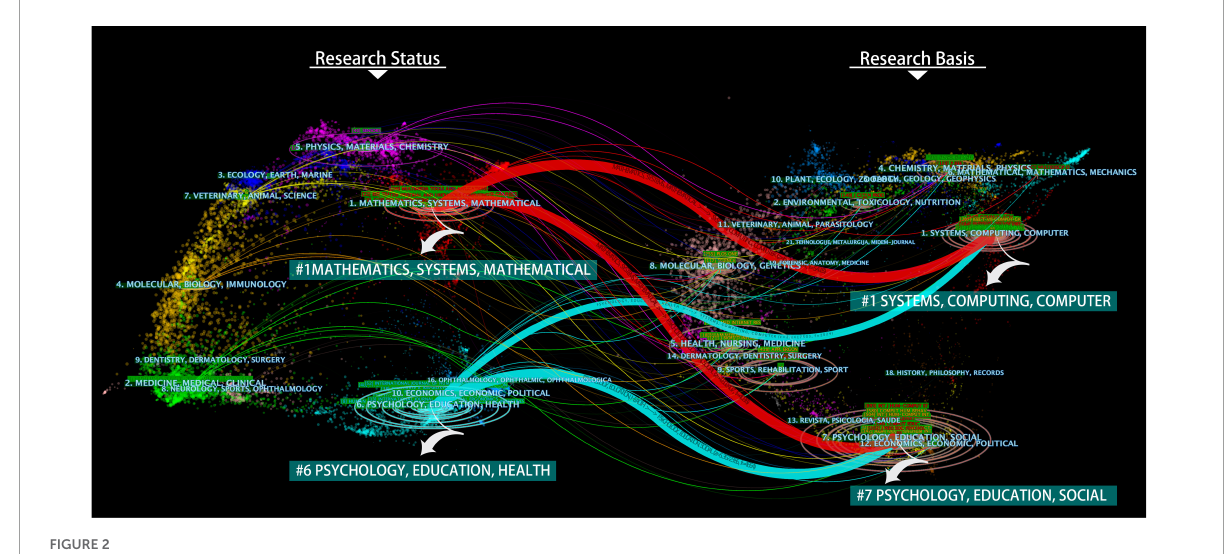
FIGURE2 Flow trajectory of user experience core